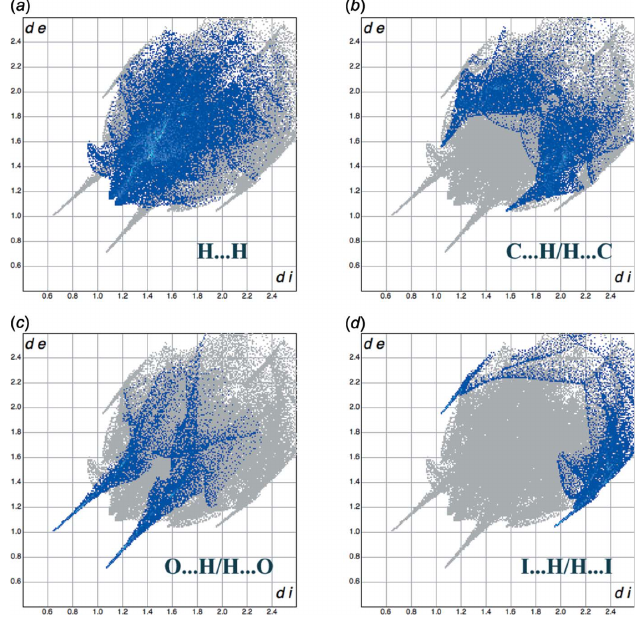
Figure 6 Two-dimensional fingerprint plots delineated into different contact types ( a )–( d ) for the title compound. Each blue dot represents a 0.01 A˚ bin of points on the Hirshfeld surface, with coordinates corresponding to distances (A˚ ) from the points to the nearest interior ( d i ) and exterior ( d e ) nuclei. Increasing intensity of overlapping points is shown by a colour coding from blue to cyan. The grey background contours correspond to the plot integrated for all contact types.